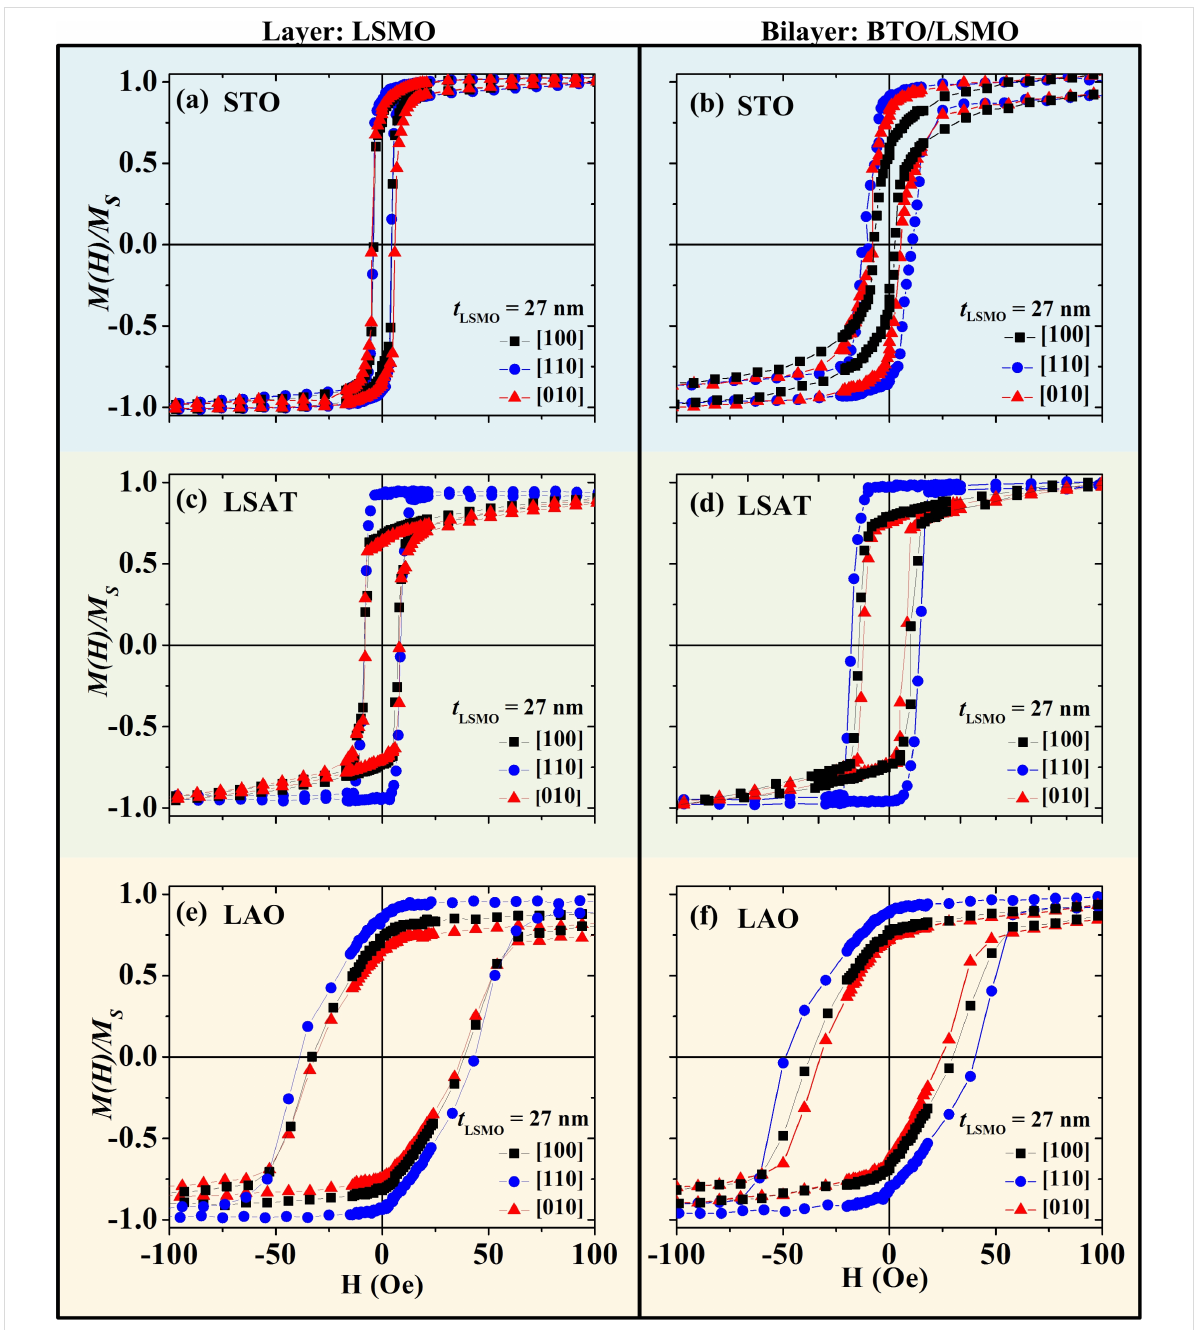
Figure 3: Normalized isothermal hysteresis loops at 300 K for LSMO films grown on (a) STO, (c) LSAT and (e) LAO substrates, and for BTO/LSMO bilayers grown on (b) STO, (d) LSAT and (f) LAO substrates with applied field along [100] (black squares), [010] (red triangles), and [110] (blue circle) in-plane directions.